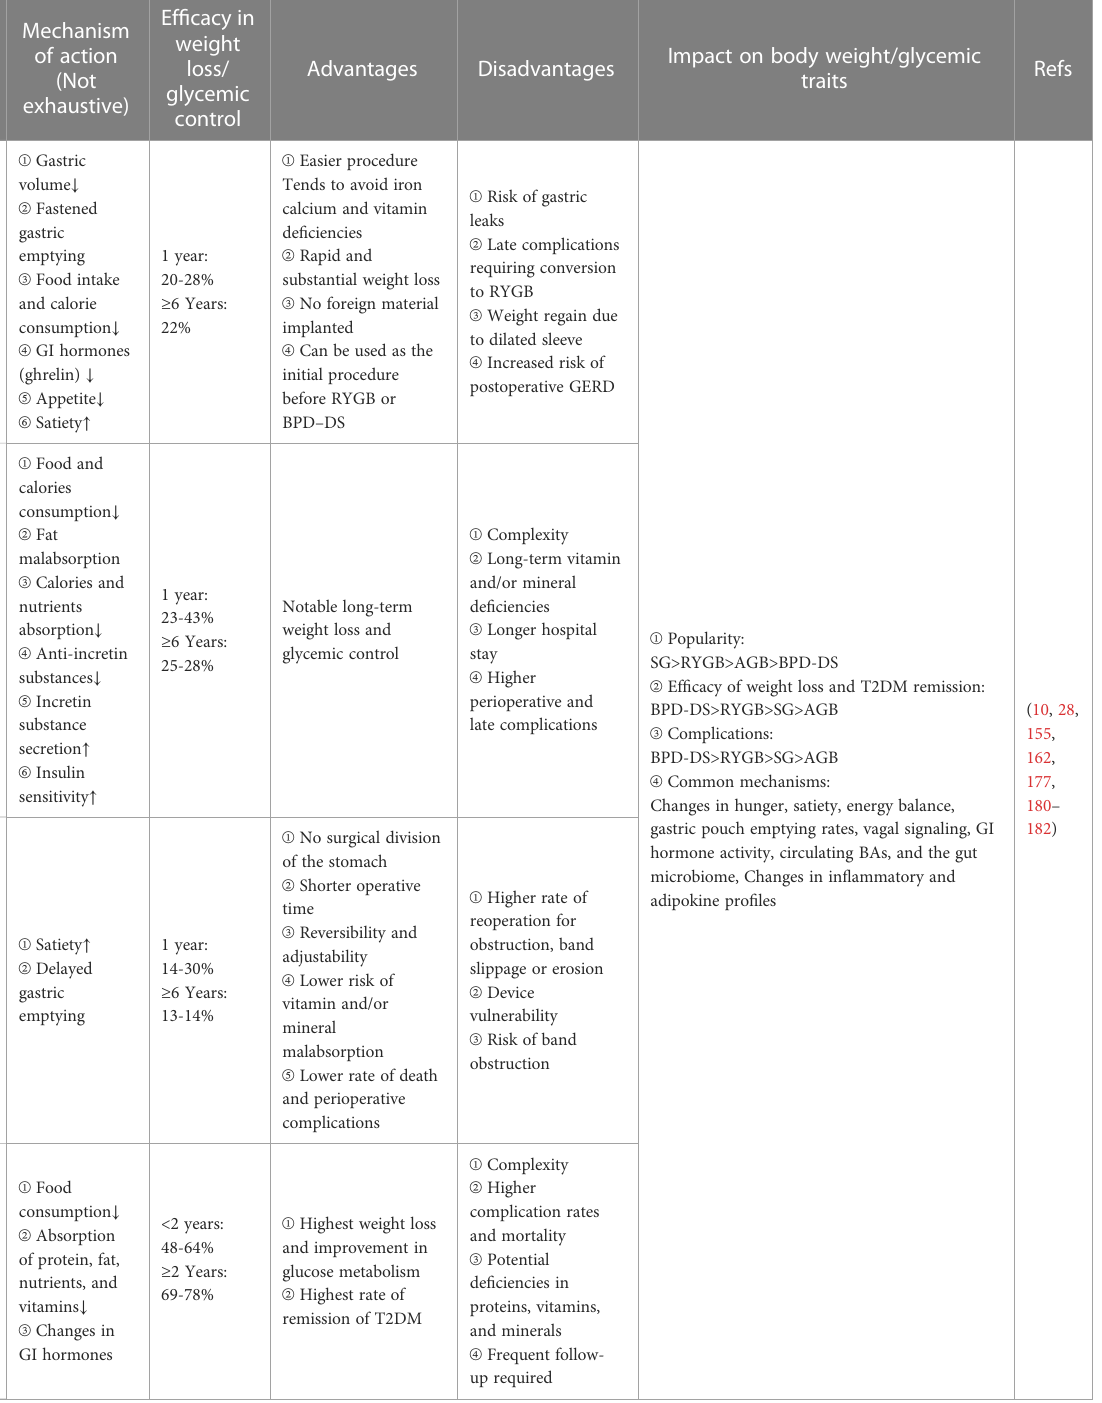
TABLE 3 The effects of bariatric surgery on managing obesity and